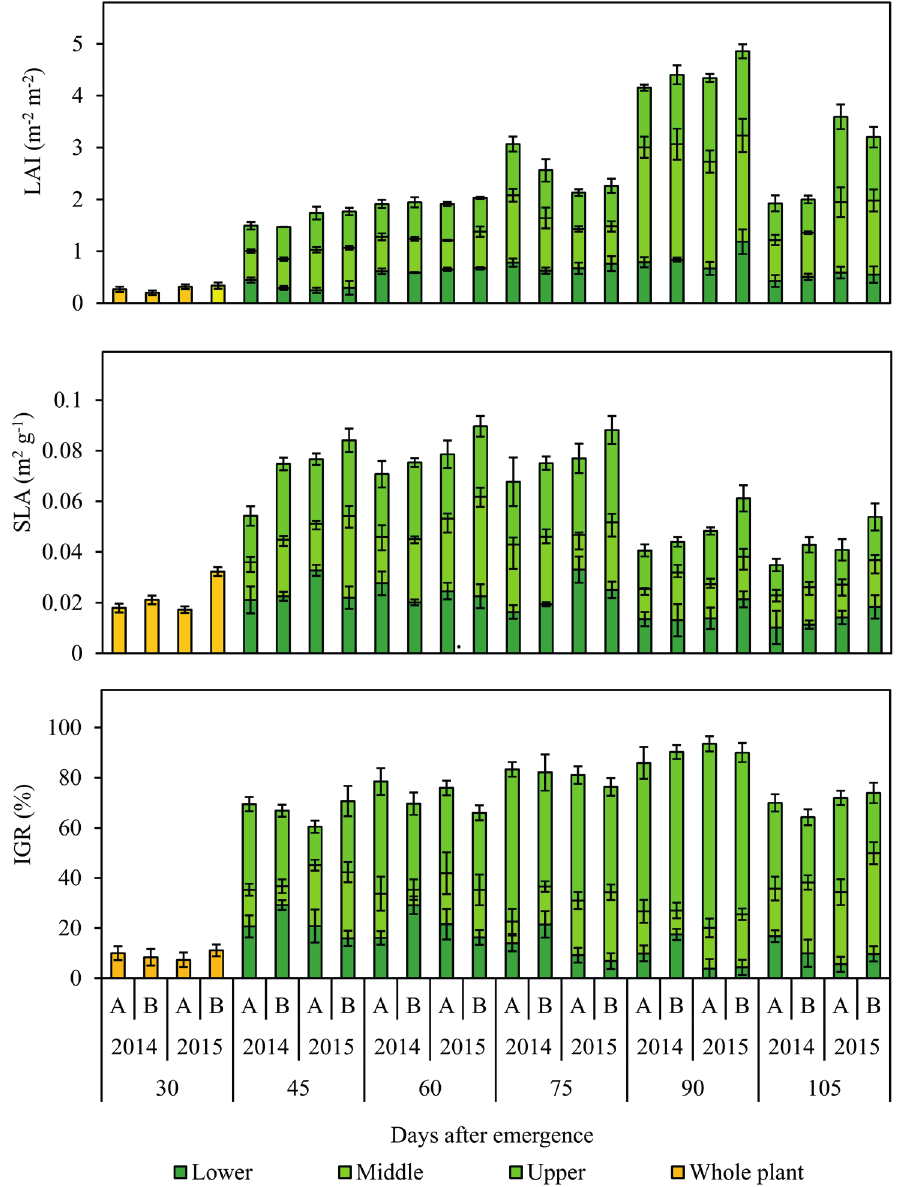
Figure 6 - Leaf area index (LAI), specific leaf area (SLA) and intercepted global radiation (IGR) in different canopy strata of the soybean cultivars ‘A’ – NA6411 and ‘B’ - TEC6029 in two crop years (2013/2014 and 2014/2015) throughout all evaluation periods in a field experiment in Frederico Westphalen, Brazil. error bars represent the standard deviation of mean values ±